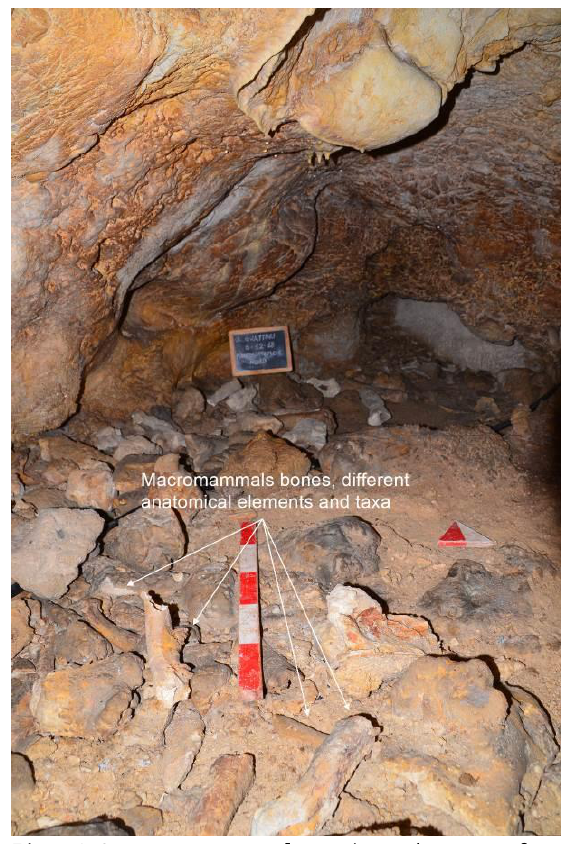
Figure 2. Some macromammals remains on the cave surface